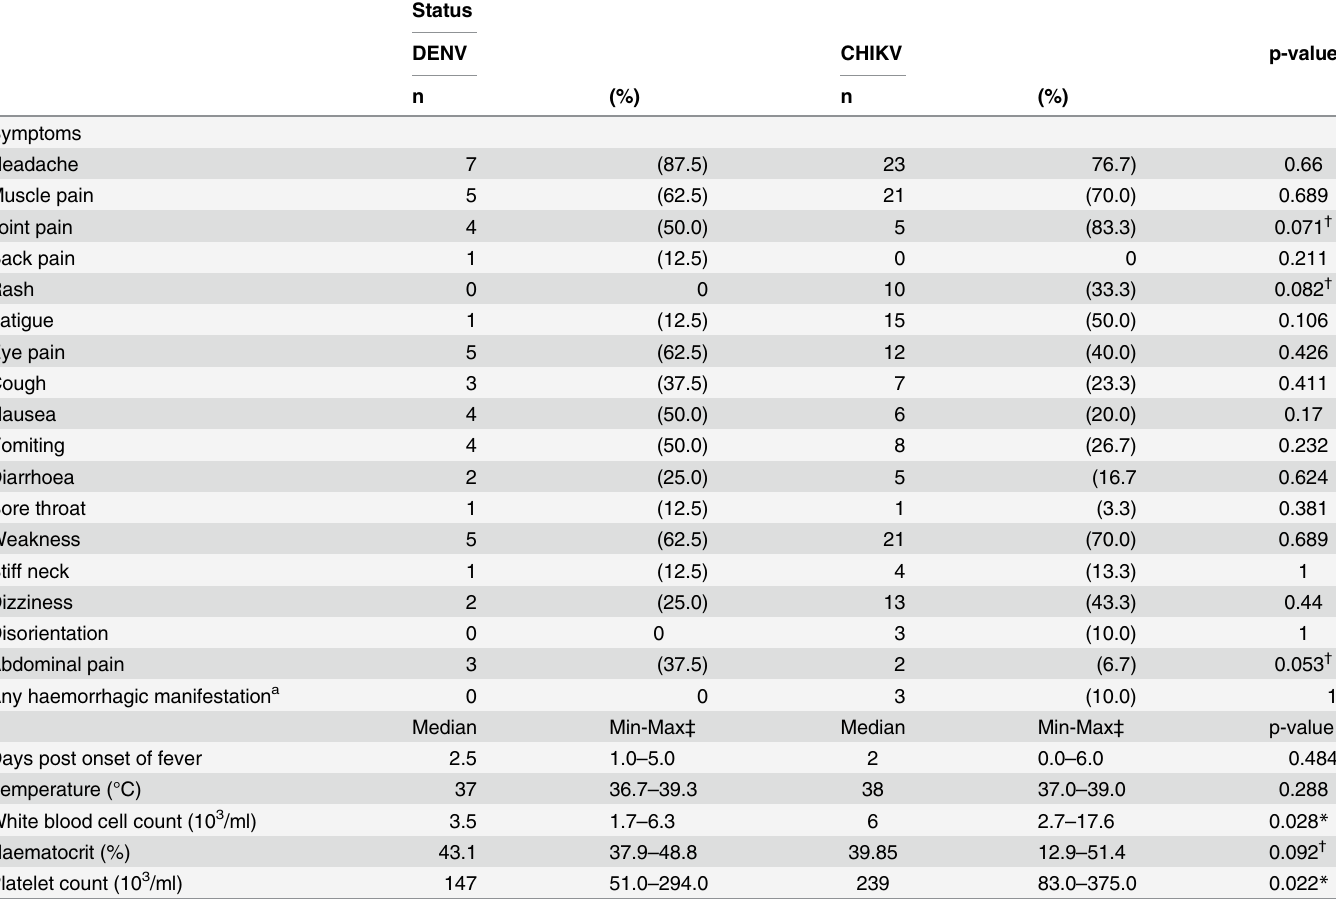
Table 3. Bivariable associations between symptoms and clinical characteristics of patients of the APCF of the EWMSC, T&T (Dec 2013 – Nov 2014) and having a confirmed infection l= with either DENV or